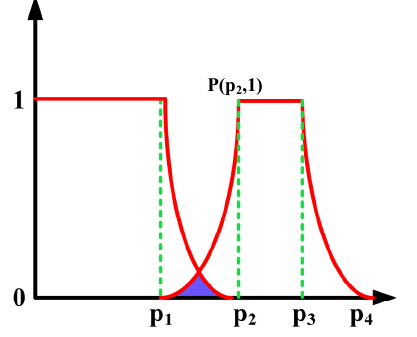
Figure A4. The final De-Blurring control result for nine fuzzy rules in the CMFI system.